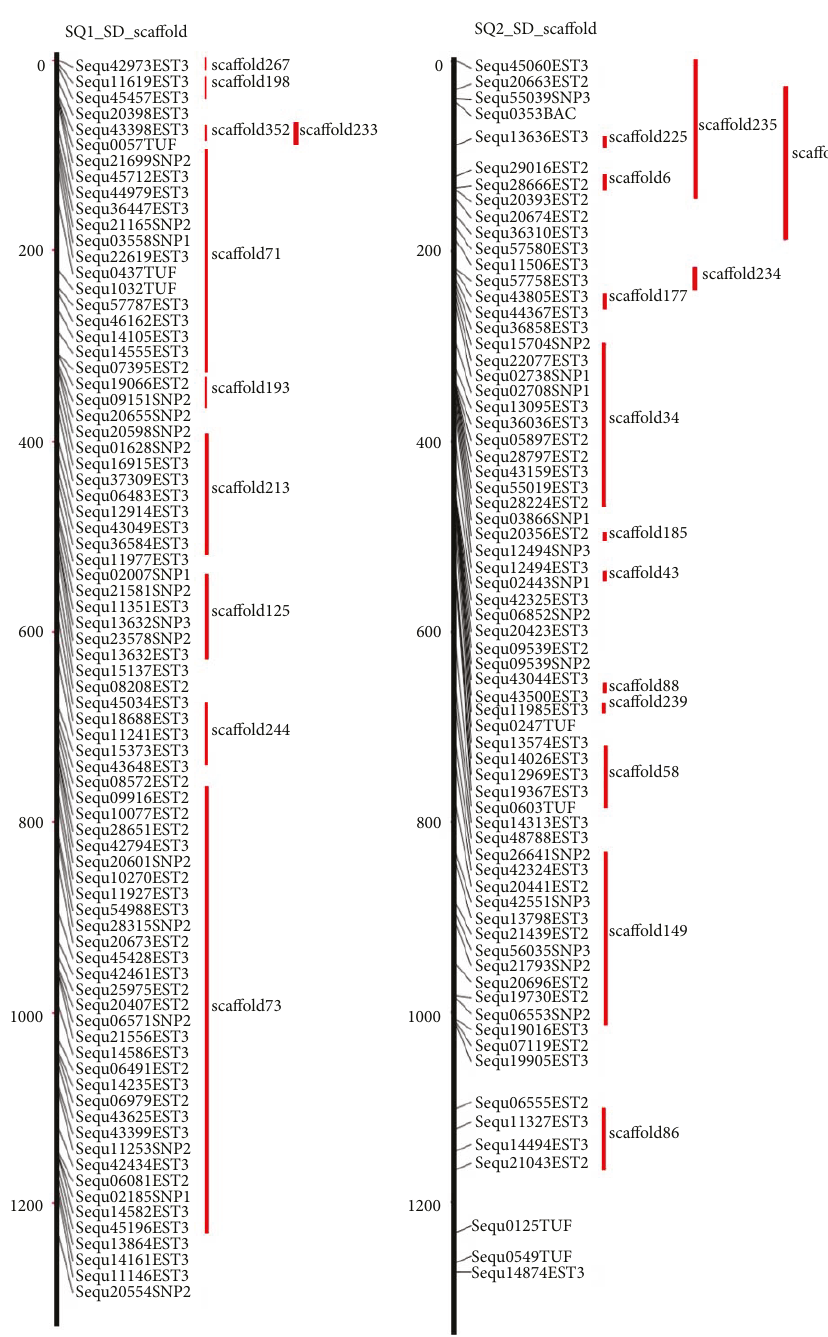
Figure 1: Greater amberjack sca ff olds aligned onto two linkage groups of the yellowtail radiation hybrid physical map. A representative part of the yellowtail radiation hybrid (RH) physical map is shown with the greater amberjack sca ff olds aligned. Numbers on the left indicate distance (cR) from the top of the RH map. Black lines indicate chromosomes. Red lines on the left indicate sca ff old lengths. Seq numbers indicate mapped sequence number. Sca ff old numbers identify the aligned sca ff